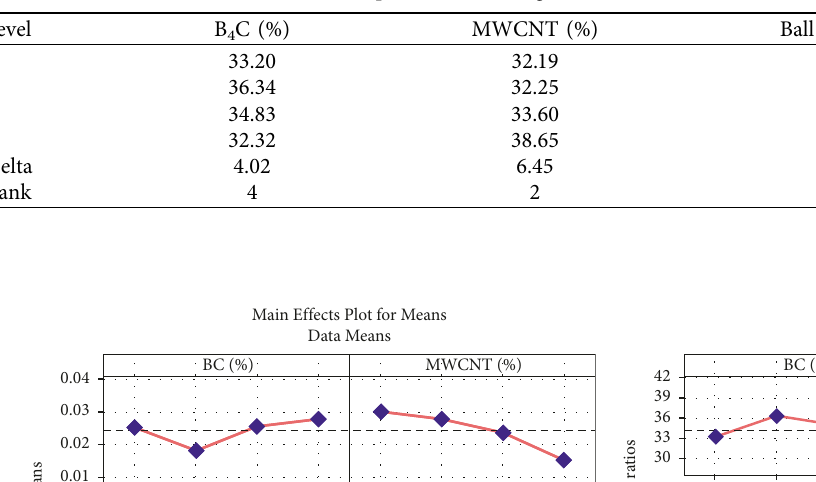
Table 5: Response table for signal-to-noise ratios (wear). Smaller is better.